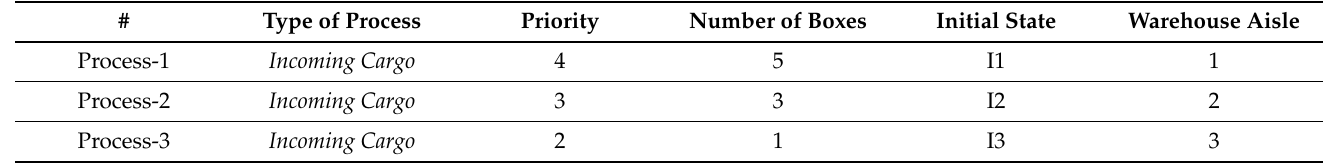
Table 1. Description of Experiment 1: Priority